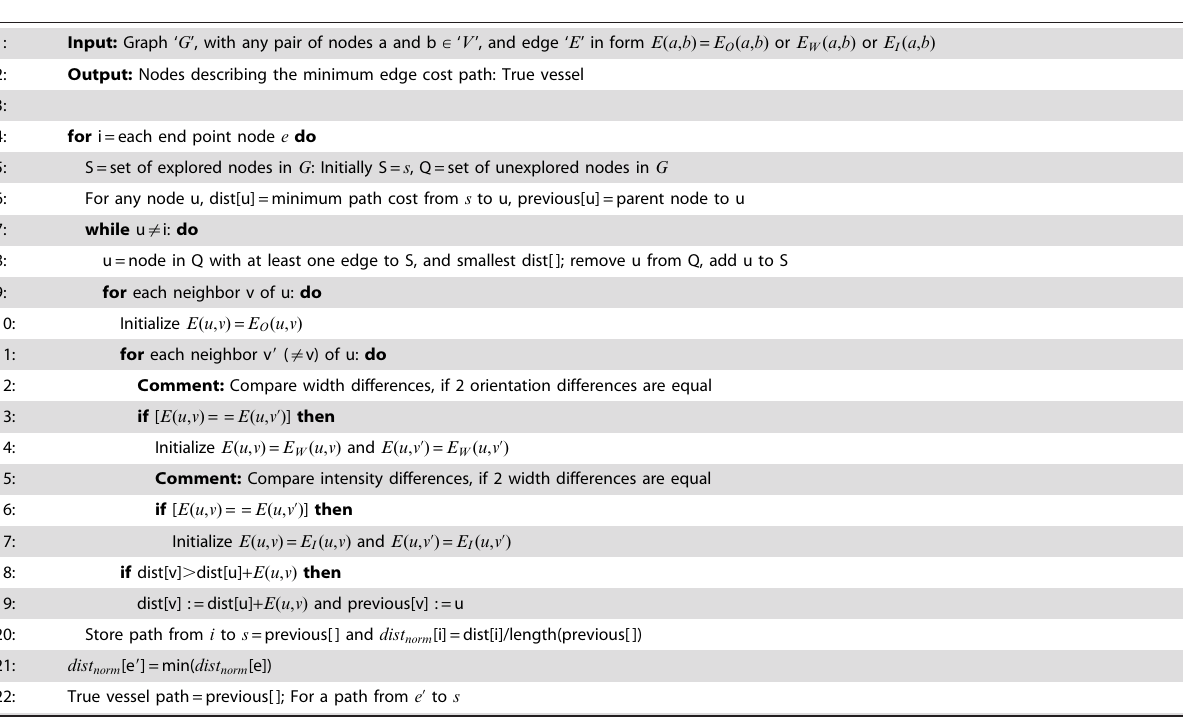
Table 1. Algorithm 1: Structural mapping using Dijkstra’s graph search.